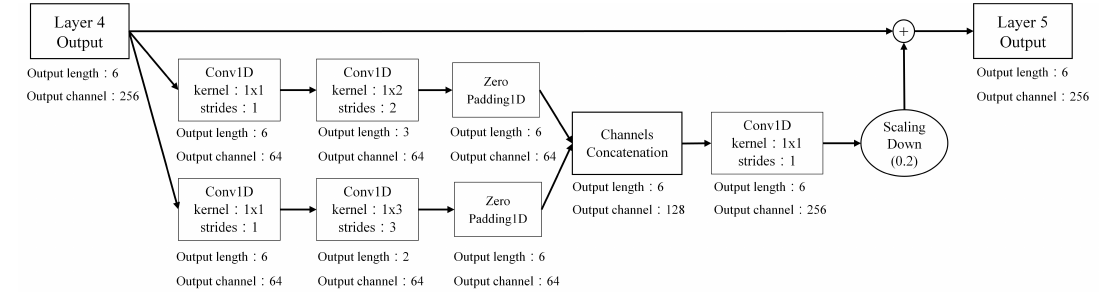
Figure 10. The parameters of the inception module with short-cut. It contains three paths. The top path is the short-cut for connecting the output of layer 4 to the input of layer 6. The remaining two paths are convolution modules and zero padding